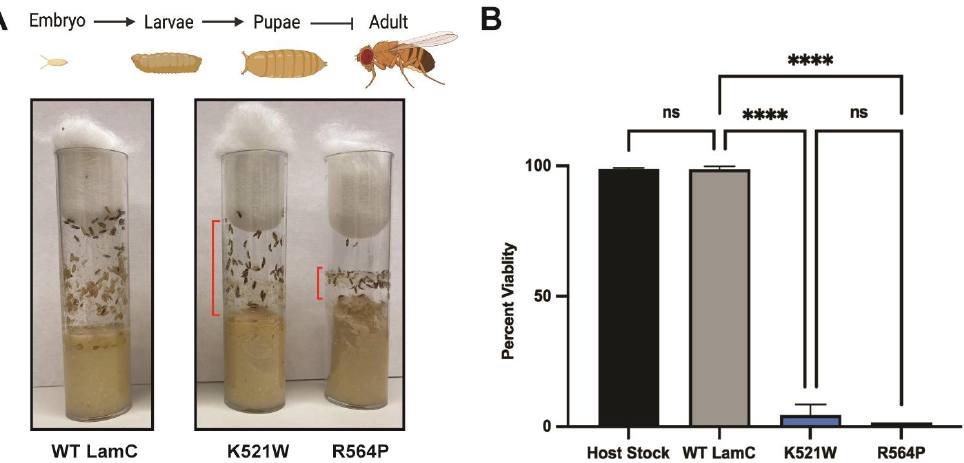
Figure 5. Larval body wall muscle-specific expression of mutant LamC reduces adult viability. ( A ) Graphical representation of the Drosophila lifecycle stages is shown at the top (created with BioRender.com, access date 12/2022). Vials containing larvae with larval body wall muscle-specific expression of either wild-type or mutant LamC are shown. Red bars indicate the larval movement up the side of the vial. ( B ) The percentage adult viability is represented as # living adults # living adults + # dead pupae × 100. The average percentage ± the standard deviation of the mean are shown. Total progeny (255–326) was counted from multiple individual crosses for each genotype. Statistical significance was determined using the Fisher’s exact test (GraphPad Prism version 9.5.0, GraphPad Software, San Diego, CA, USA). No statistical difference, ns; p < 0.001; **** p <